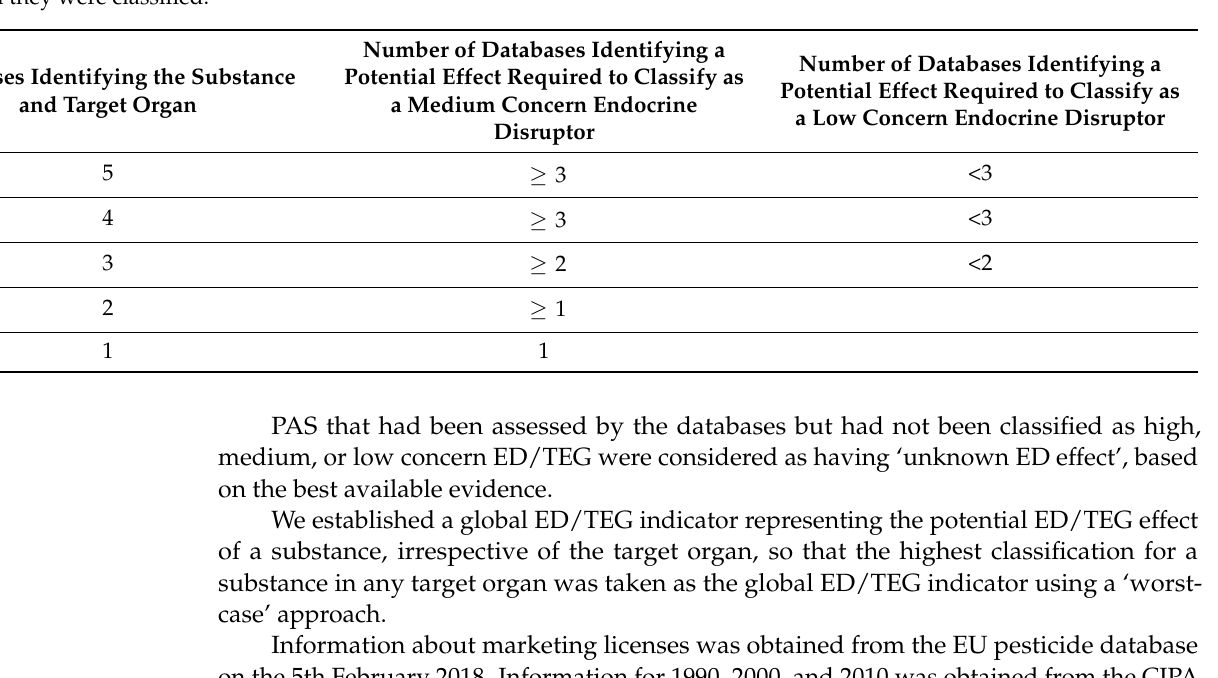
Table 1. Classification of ‘potential ED/TEG’ into ‘medium concern’ and ‘low concern’ based on the number of databases in which they were classified.